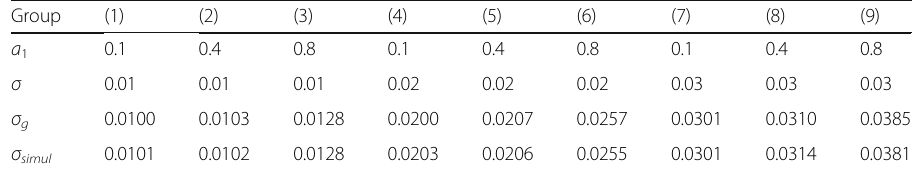
Table 1 Results on risk for the AR (1) process. The table reports the actual standard deviations of the simulated returns and their theoretical values for nine AR (1) processes with different parameters. The actual standard deviation of the simulated returns is denoted by σ simul , and its theoretical value is denoted by σ g